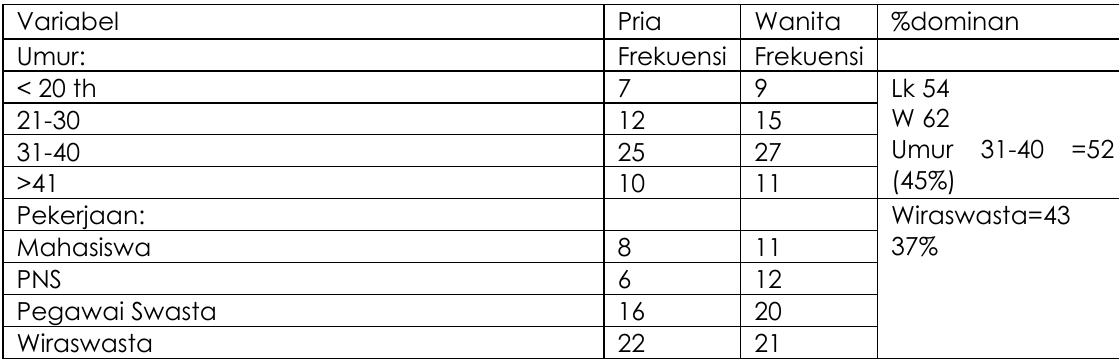
Table 2. Hasil analisis karakteristik